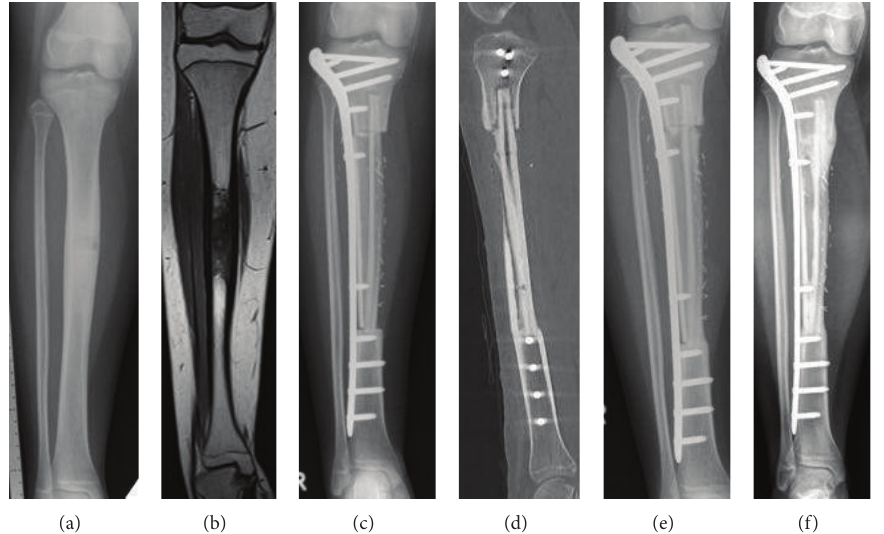
Figure 4: X-ray, CT and MRI imaging in a 14-year-old female patient with Ewing’s sarcoma of the right tibia: before operation (a)-(b); three months after operation (c), seven months after operation: no consolidation at the proximal graft host junction (d)-(e); 21 months after operation: fully integrated fibula; and allograft